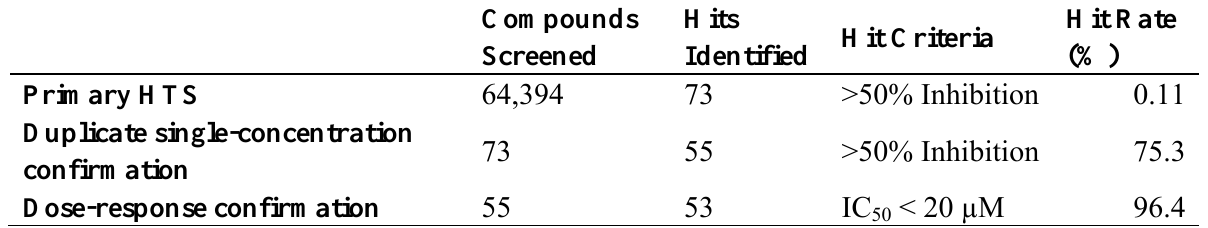
2. Summary of High-Throughput Screen for Tissue-Nonspecific Alkaline Phosphatase with the Luminescent Assay.